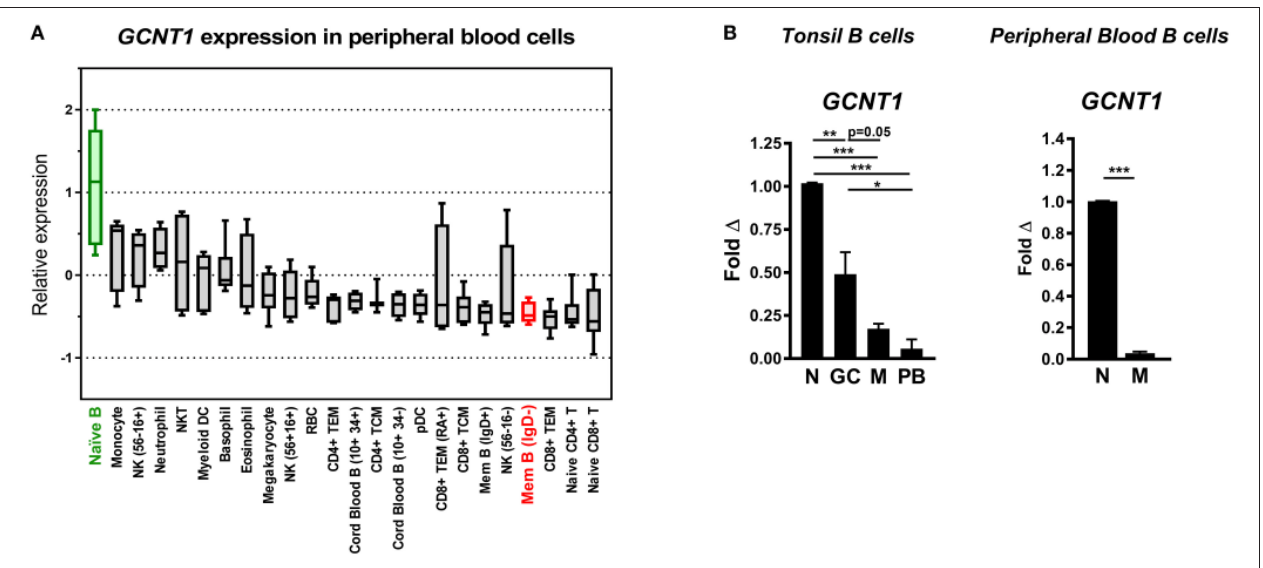
FIGURE 8 | Loss of O-glycan complexity with differentiation is associated with downregulation of the Core 2 branching enzyme GCNT1. (A) Relative mean GCNT1 expression in peripheral blood cells, analyzed from the publicly available dataset GSE24759. Box and whiskers depict minimum value, maximum value, median, and interquartile range. (B) qRT-PCR analysis of transcript levels of GCNT1 in primary tonsil and peripheral blood B cell subsets. Data were normalized to the housekeeping gene VCP and are depicted relative to naïve B cells. For (B) , n = 3 distinct tonsil or peripheral blood specimens. Bars and error bars in (B) depict mean and SEM. * p ≤ 0.05, ** p ≤ 0.01, *** p ≤ 0.001. N, naïve; GC, germinal center; M, memory; PB,